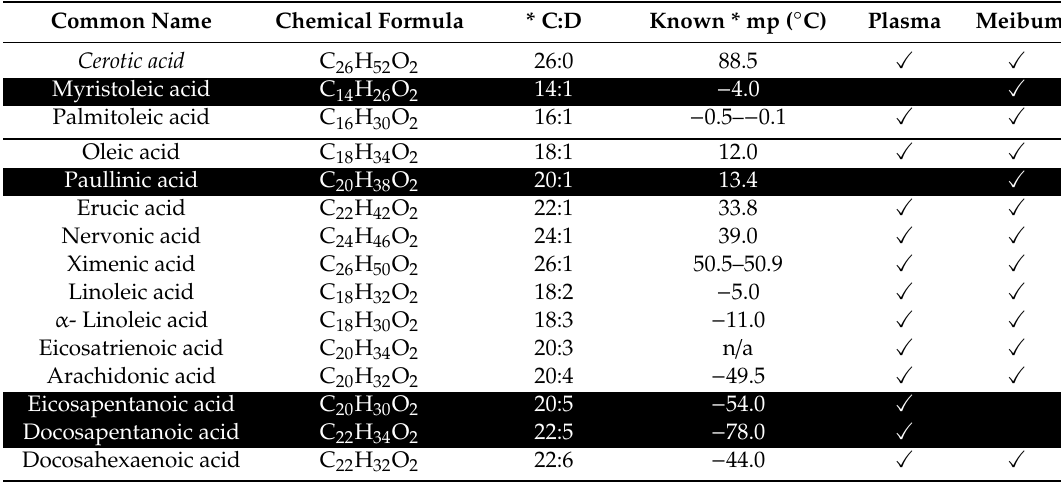
Figure 6A. In meibum, SM-16:0 was the most abundant and SM-16:1 was the least abundant species. SM-18:1 and SM-22:1 were significantly elevated after HFD feeding; Figure